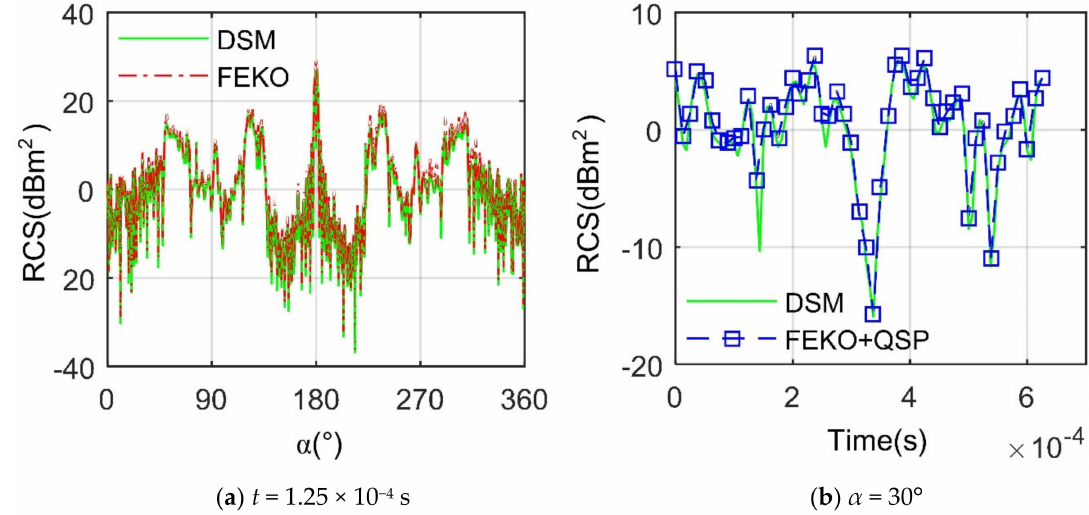
Figure 2. Verification of the dynamic scattering method (DSM) with m fan , β = 0 ◦ , and f R = 6 GHz.